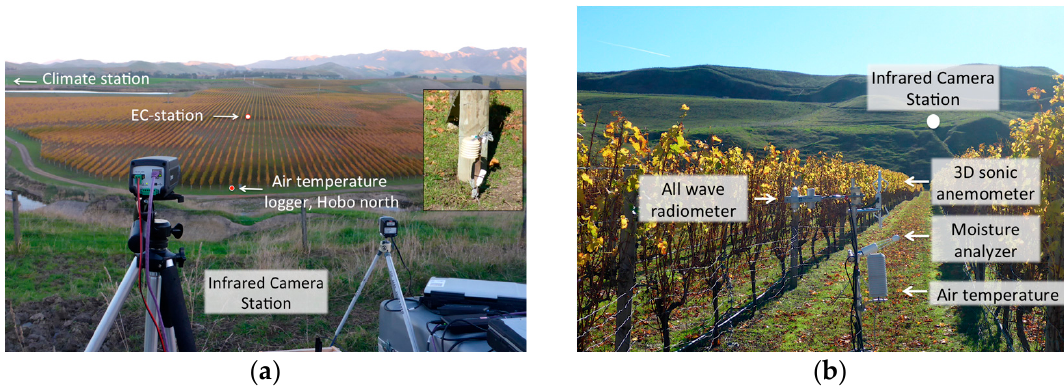
Figure 1. ( a ) The vineyard site covering most of the field of view of the two longwave infrared cameras shown on tripods in the foreground. The near-ground Hobo temperature logger is shown in the small figure inset; ( b ) A close up on the eddy covariance system (or EC-station in left panel) placed in the center of the camera’s field of view. Table 1. Instrumentation specifications and measured variables.